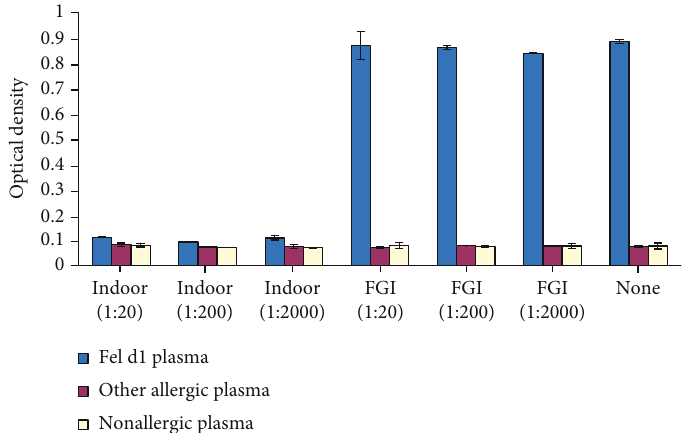
Figure 1: Chimeric ELISA evaluation of a rabbit polyclonal anti-Fel d1 antibody (indoor) and rabbit monoclonal anti-Fel d1 (FGI) on IgE binding in di ff erent plasma samples. Chimeric ELISA analysis of IgE blocking e ff ect of rabbit anti-Fel d1 polyclonal “ Indoor Poly ” (Indoor Biotechnologies, Cat# PA-FD1) and rabbit anti-Fel d1 monospeci fi c “ FGI ” antibodies (FabGennix International, Cat# FELD1-121AP). Both antibodies were tested at serial dilutions of 1:20 to 1:2,000,000. Cat saliva samples incubated with bu ff er only (none) showed high Fel d1-to-IgE binding in cat allergic plasma, but not in noncat allergic plasma and nonallergic plasma. Binding of Fel d1 in cat allergic human plasma was reduced by Indoor Poly versus control (none) at dilutions to 1:2000 ( p < 0 : 001 ) but was not a ff ected by the FGI antibody ( p > 0 : 10 ). With noncat allergic and nonallergic plasma, Fel d1 capture was una ff ected by all antibodies. ∗ Signi fi cantly di ff erent from control ( p < 0 : 001 ).